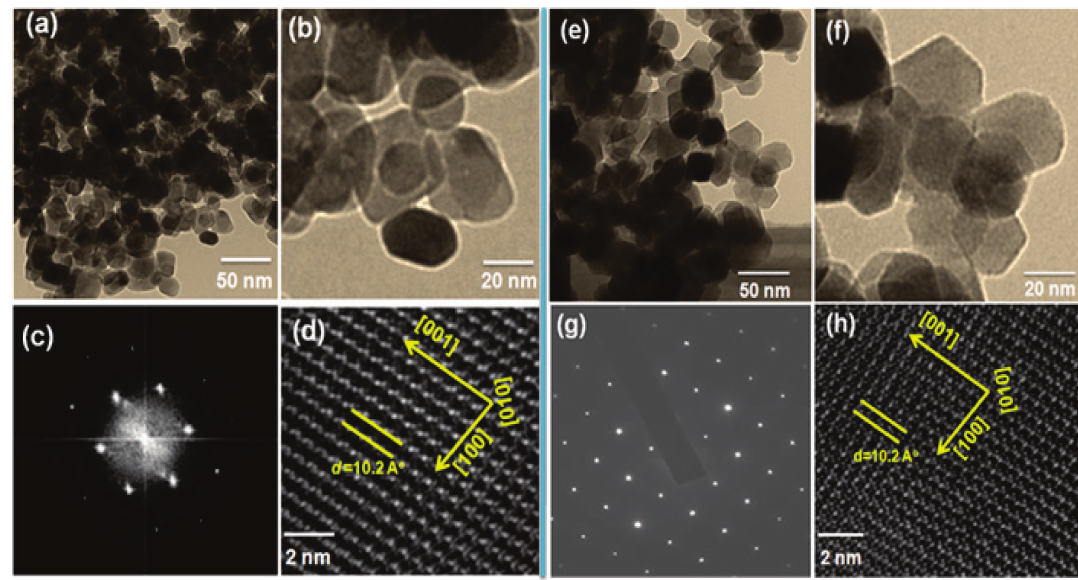
) 6H O and ( e – h )C 3 2 2